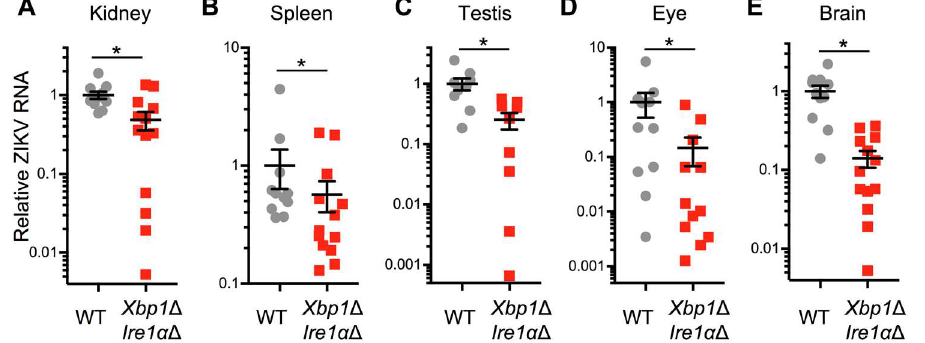
Figure 6. Genetic disruption of IRE1 α and XBP1 reduces ZIKV infection in a mouse model. Xbp1 flox / flox Ern1 flox / flox ESR Cre + ( Xbp1 ∆ Ire1 α ∆ ) or Cre − littermate (WT) mice were treated with tamoxifen to induce the expression of Cre recombinase. Mice were given interferon receptor blocking MAR1-5A3 antibody the day before and after ZIKV infection. RNA was harvested from ( A ) kidney, ( B ) spleen, ( C ) testis, ( D ) eye, and ( E ) brain three days post-infection. ZIKV RNA was measured by quantitative RT-PCR and normalized to Hprt . Values represent mean ± SEM involving Cre- ( n = 11) and Cre + ( n = 13) mice pooled from two independent experiments. Testes were obtained from the subset of mice that were male ( n = 9) for both Cre- and Cre + animals. * p < 0.05 by Mann-Whitney